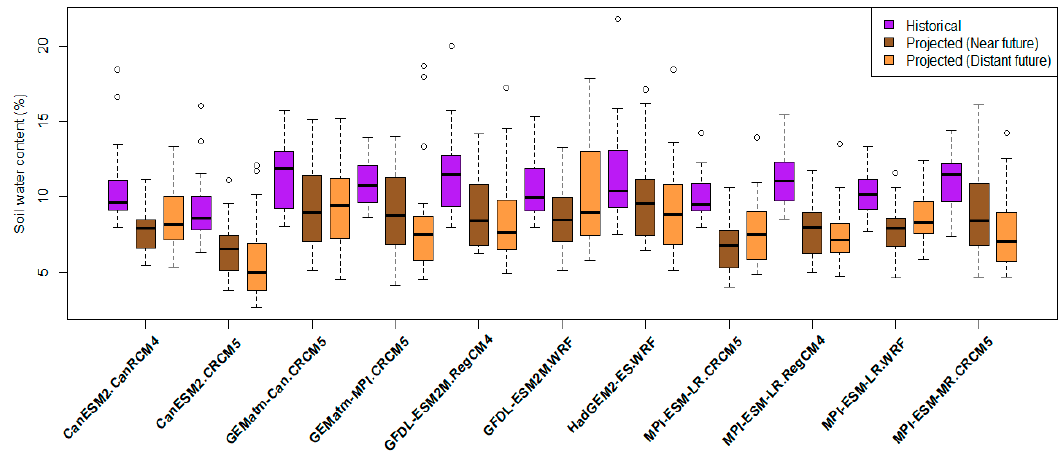
Figure 9. Box plots of the range of SWC under historical and projected changes.